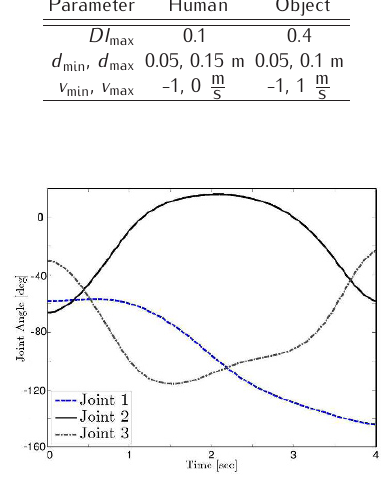
Figure 11. CRS-F3 joint